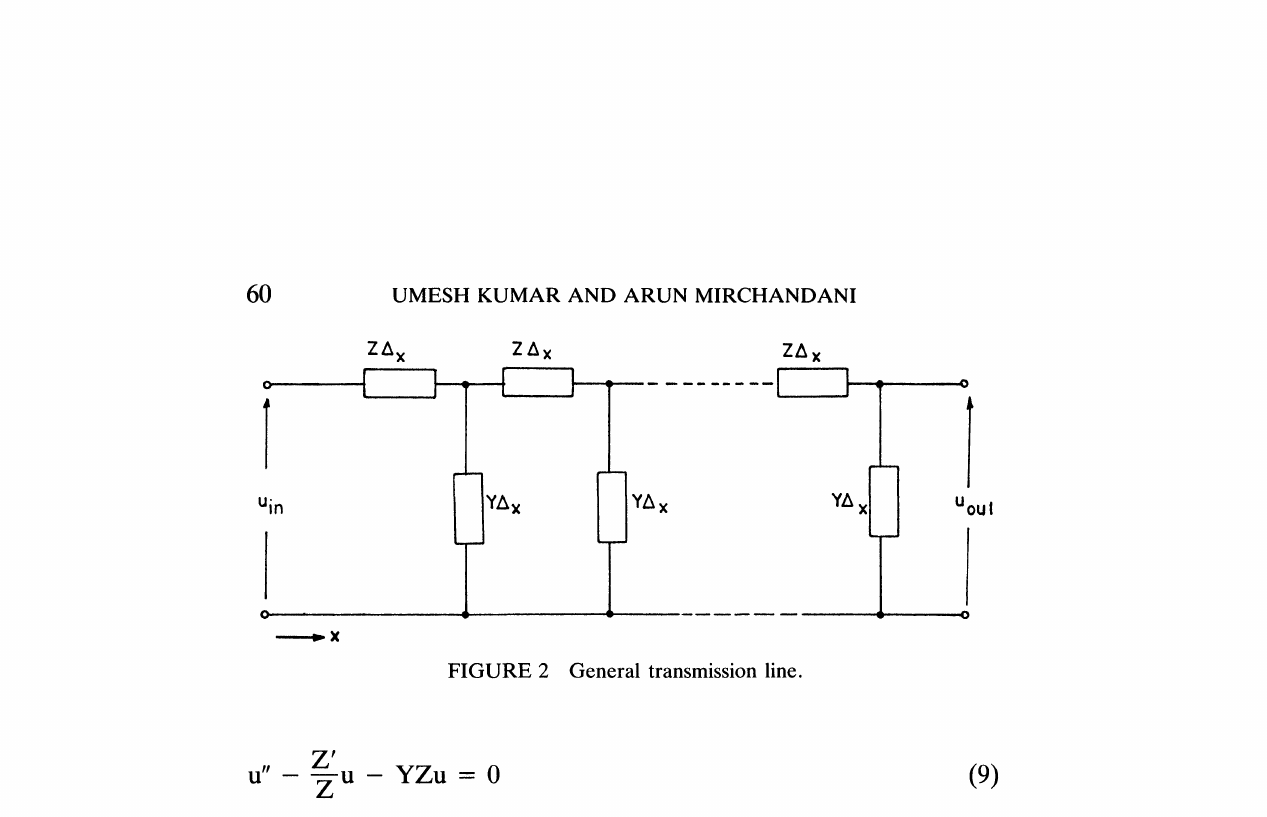
FIGURE 2 General transmission